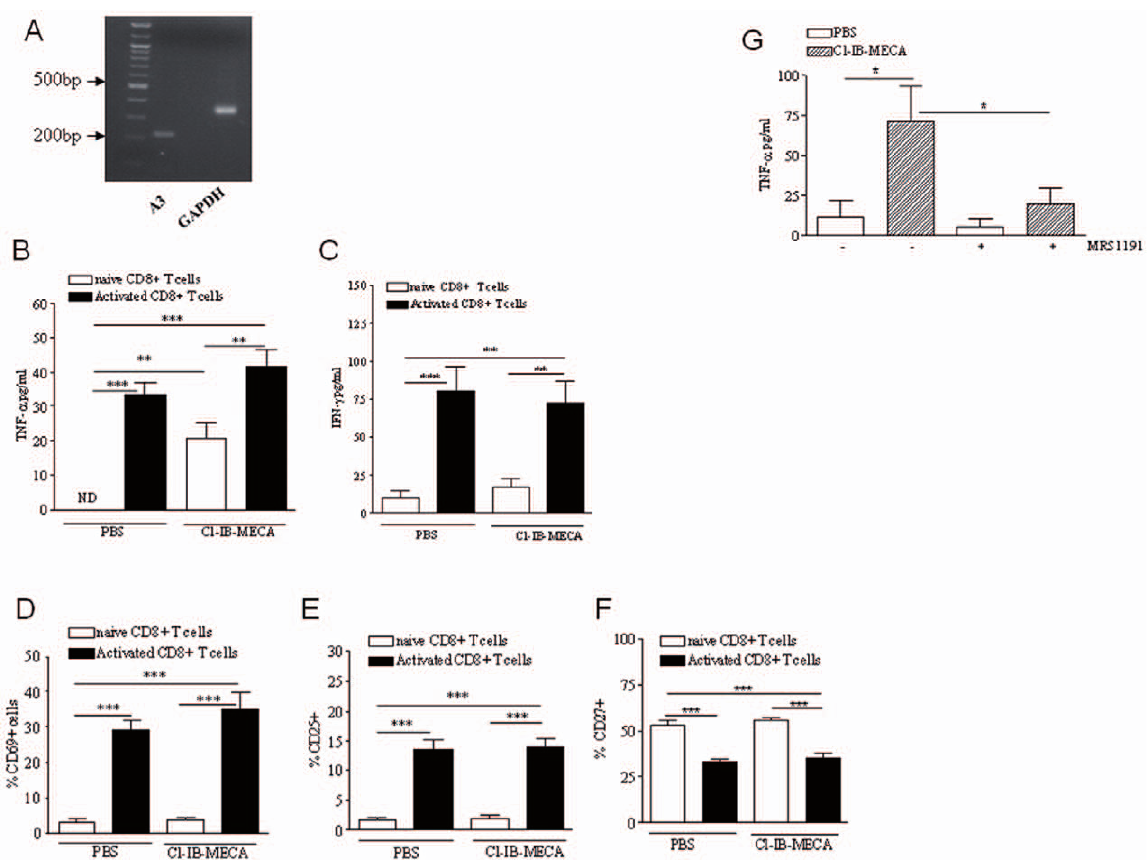
Figure 4. Cl-IB-MECA stimulation of CD8 + T cells invitro favors TNF- a production. A ) A3 adenosine receptor expression by CD8 + T cells. B ) TNF- a levels in the supernatants of naı¨ve (white bars) and activated (black bars) CD8 + T cells after Cl-IB-MECA treatment measured at 24 h by ELISA. C ) INF- c production measured in the supernatants of naı¨ve (white bars) and activated (black bars) CD8 + T cells stimulated or not with Cl-IB-MECA (0.1 m g/ml) and measured at 72 h by means of ELISA. . D ), E ) and F ) percentage of CD69 + cells, CD25 + cells or CD27 + cells, respectively, after Cl-IB- MECA treatment. G ) MRS1191 blocked the stimulatory effect of Cl-IB-MECA on TNF- a release. Data are from two independent experiments and represent mean 6 SEM, n=8 for each experiment. Statistical difference was determined by Student’s t test. *p ,